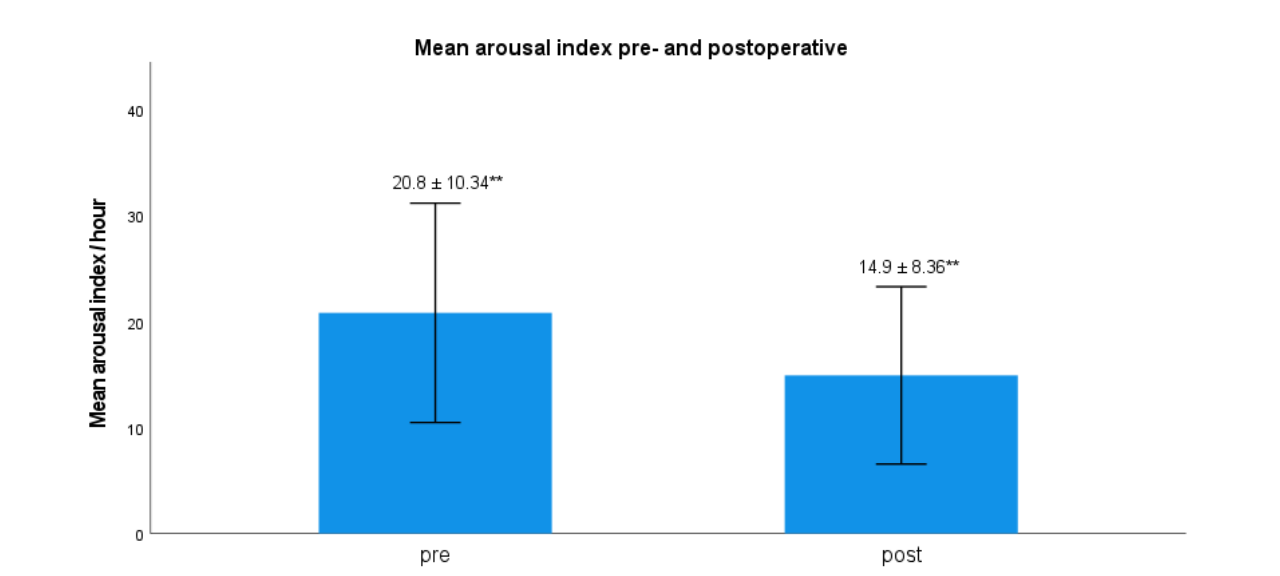
Figure 3. Comparison of arousal index pre-and postoperatively: 20.8 ± 10.34, 14.9 ± 8.36, p < 0.01